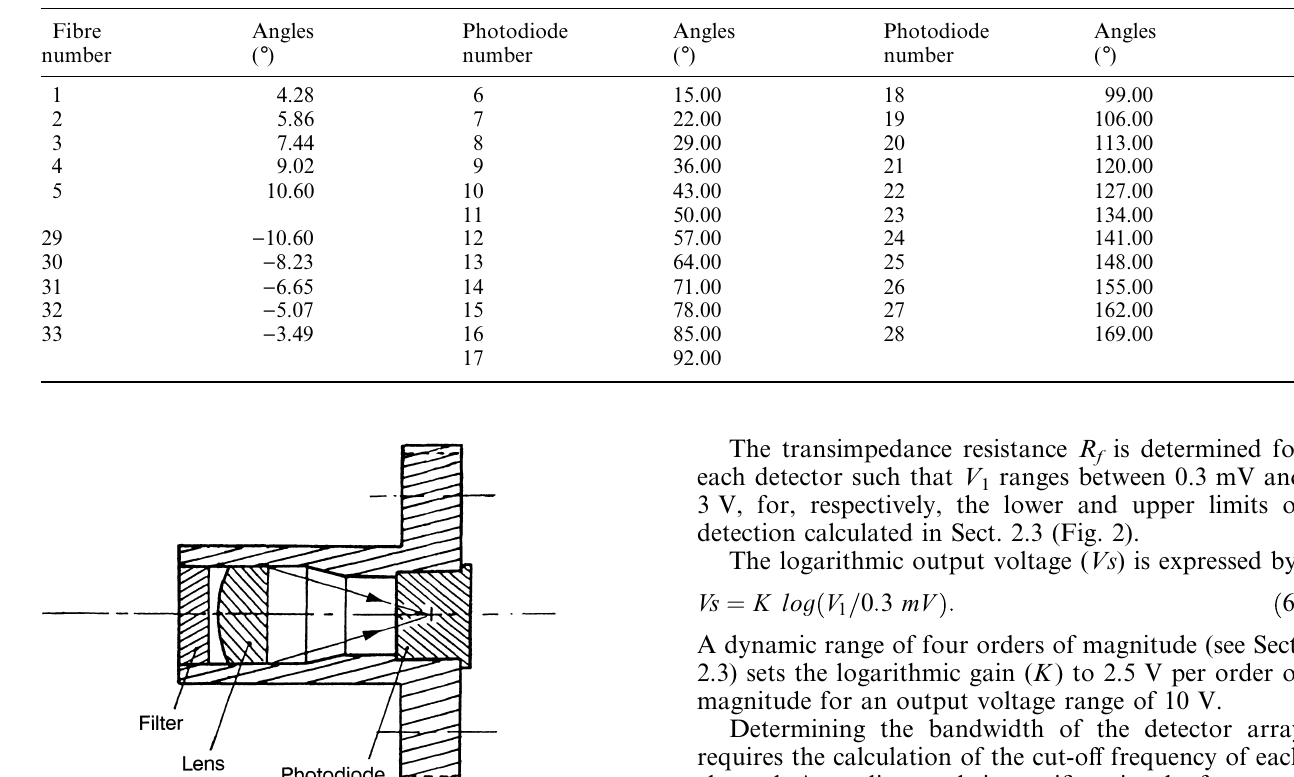
Table 3. Subtended angles relative to each detector